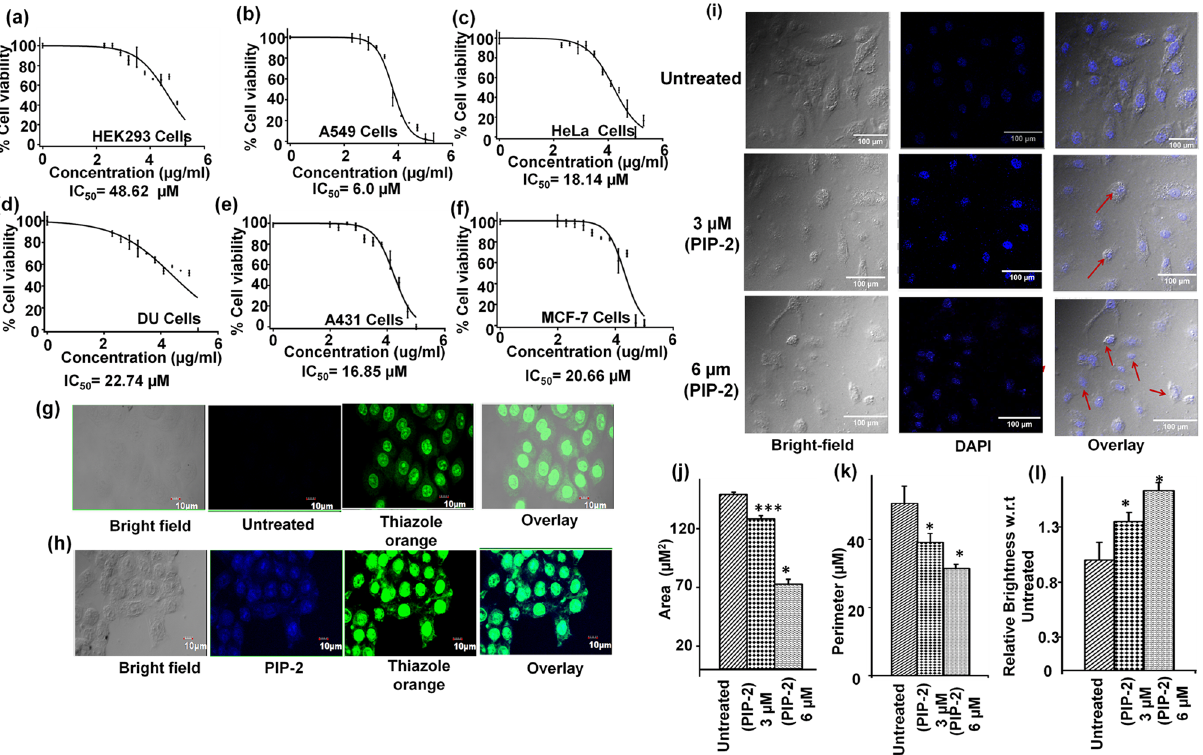
Figure 8. Cell viability assay of PIP-2 with HEK 293 and different cancer cells. ( a – f ) The plot represents the cell viability of PIP-2 with ( a ) HEK 293 ( b ) A549, ( c ) HeLa cells, and ( d ) DU cells ( e ) A431 cells ( f) MCF-7 cells. Co-localization of PIP-2 in A549 cells. ( g , h ). Representative confocal images of A549 cancer cells untreated ( g ) and treated ( h ) with PIP-2 (100 µM). Scale bar 10 µm. Apoptosis mediated changes occur upon treatment with PIP-2 ( i – k ). ( i )The morphological changes in the nuclei in cultured A549 cells upon dose- dependent treatment with PIP-2 for 24 h upon staining with DAPI. ( j , k ) The quantification analysis of different morphology parameters such as area ( j ), perimeter ( h ), and brightness ( k ). The results are the sum of three sets of experiments, with collected values expressed as means ± standard deviation. The statistical significance determined from the Student’s t-test (*P < 0.05, **P < 0.01, ***P < 0.01) by comparing the asterisks indicate the control (untreated) sample. 100 µm scale